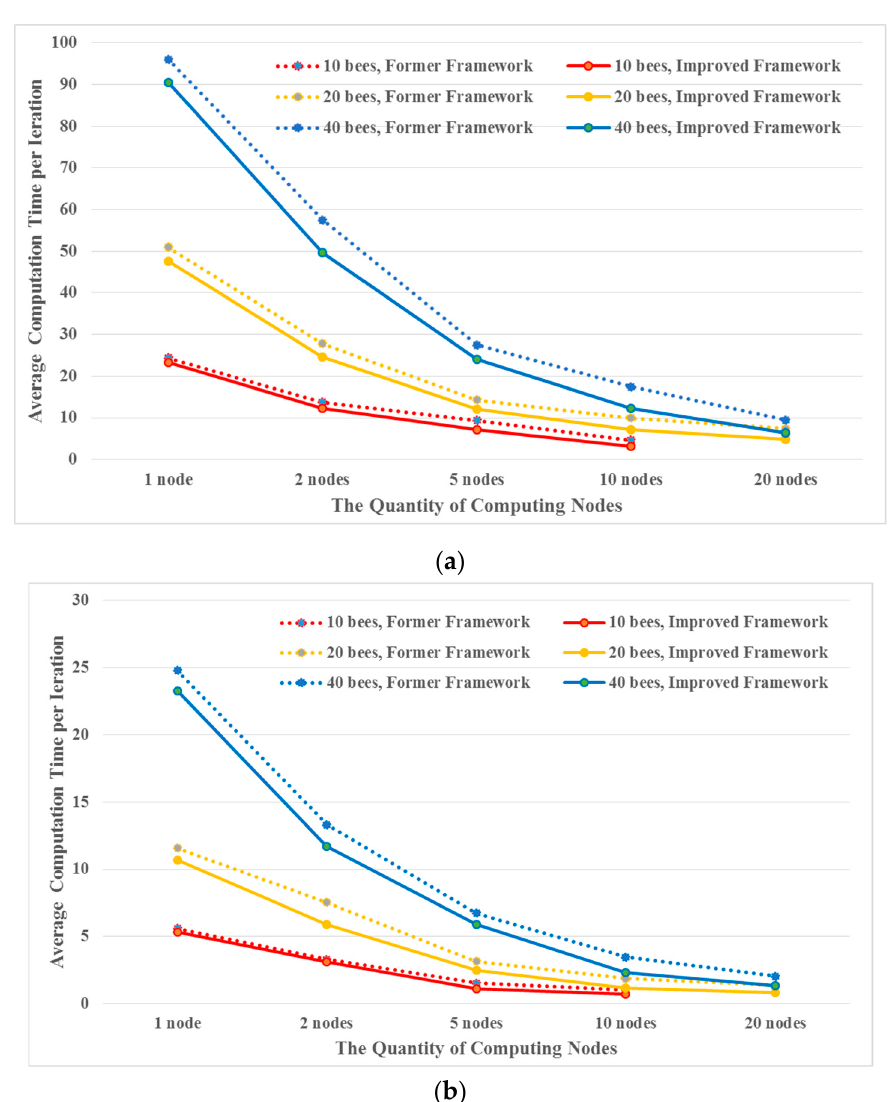
Figure 7. The average computation time per iteration for di ff erent numbers of bees and computing F igure 7 The average computation time per iteration for different numbers of bees and computing nodes. ( a ) Dataset 1 and ( b ) Dataset nodes. ( a ) Dataset 1 and ( b ) Dataset 2.